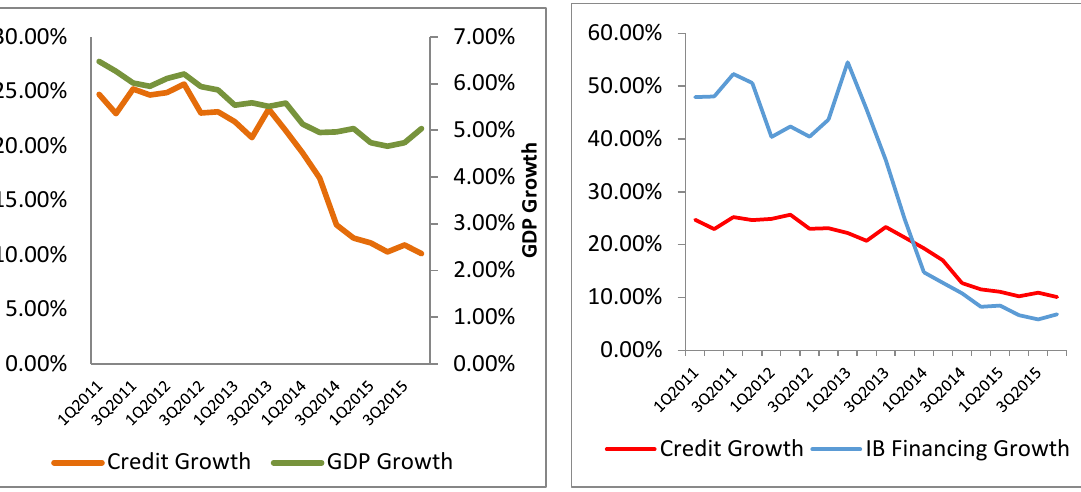
Figure 2 GDP Growth, Credit Growth and Islamic Banks Financing Growth, 2011 - 2015 Source: Bank Indonesia and OJK,